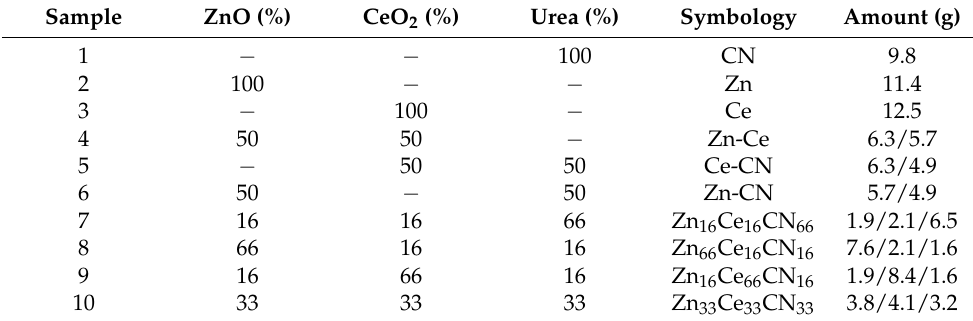
Figure 1. Three-factor simplex-centroid mixture design with three levels corresponding to urea, zinc nitrate, and cerium nitrate. Table 1. Symbology of the samples and the proportion of each compound.